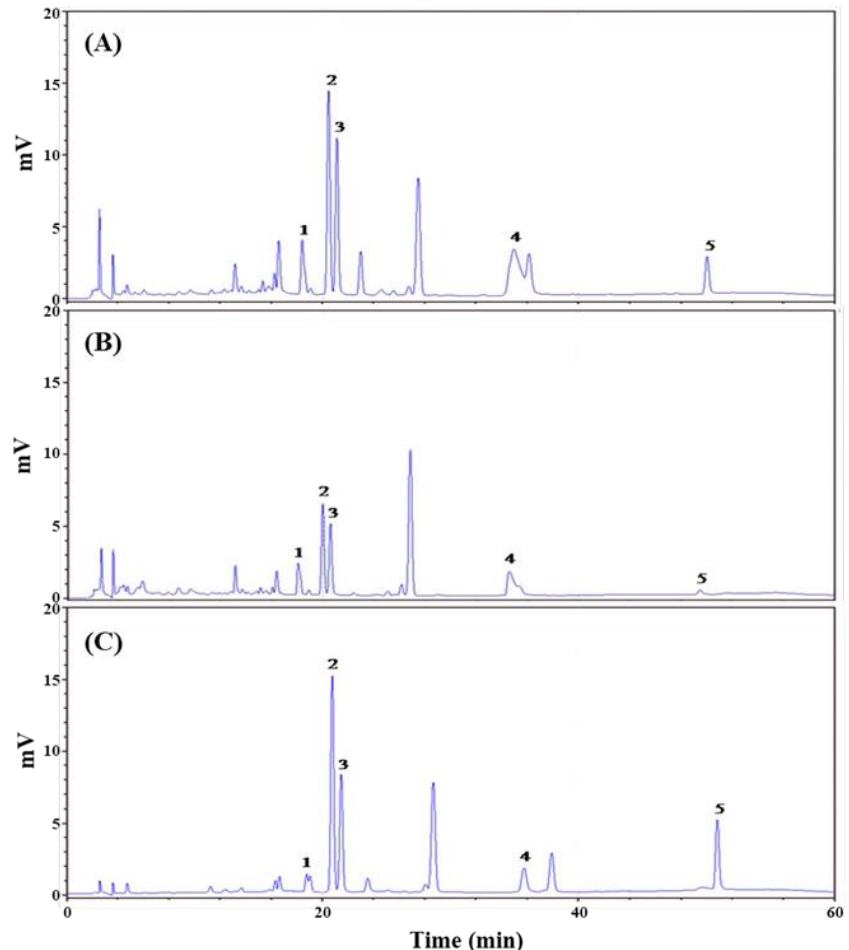
Figure 1. HPLC chromatograms of AMf extracts (( A ) AME, ( B ) AMW and ( C ) AMS). Identified compounds: rutin (1), hyperoside (2), isoquercitrin (3), myricetin (4) and quercetin (5).